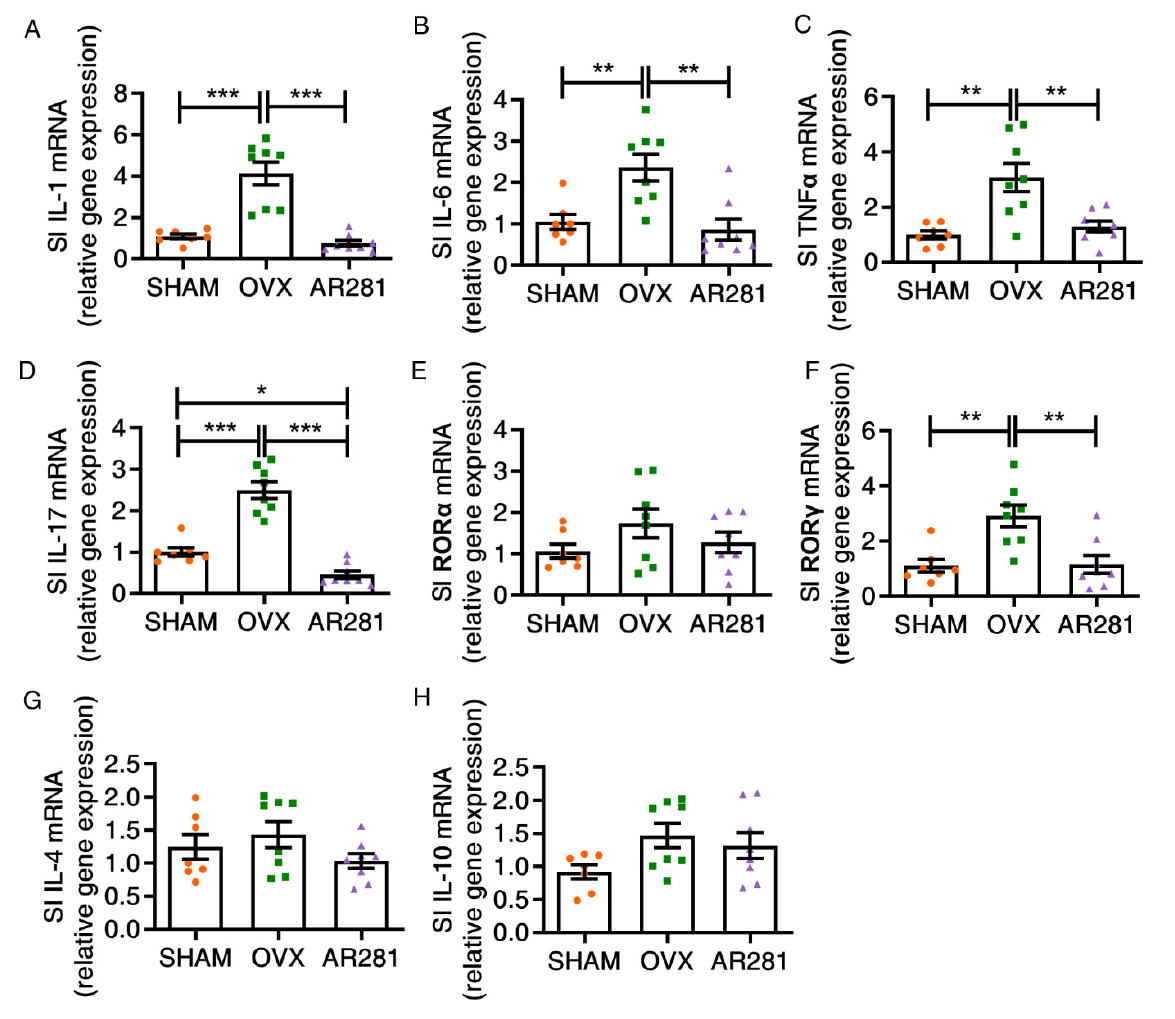
Figure 3. The effects of L. brevis AR281 on intestinal inflammation: ( A – D ) The expression of IL-1, IL-6, TNF α , and IL-17; ( E , F ) the expression of IL-17-related transcript factors ROR α and ROR γ ; ( G , H ) the expression of anti-inflammatory cytokines IL-4 and IL-10. Data are shown as mean ± SEM ( n = 8 per group, except n = 7 in the SHAM group) and are normally distributed. * p < 0.05, ** p < 0.01, and *** p < 0.001.